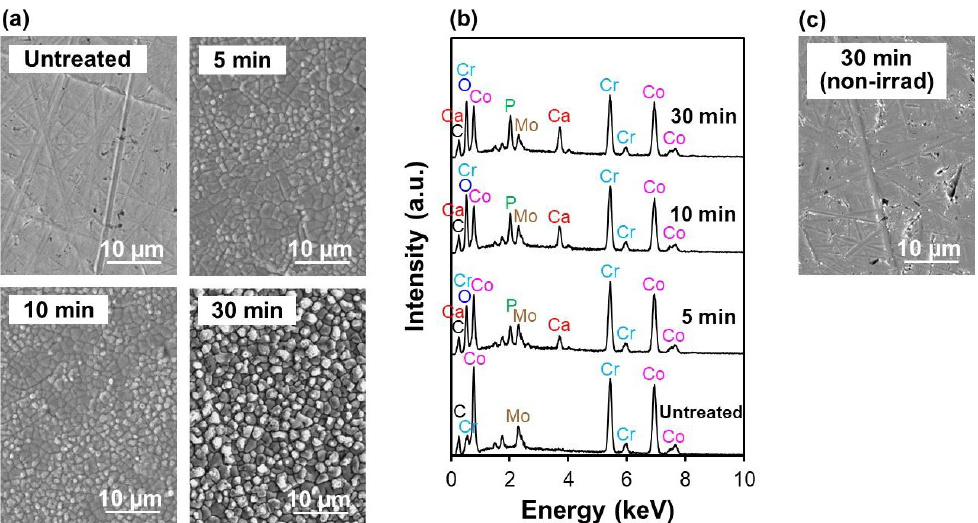
Figure 2. ( a ) Scanning electron microscopy (SEM) images and ( b ) energy-dispersive X-ray (EDX) spectra of the laser-irradiated surfaces of the untreated and LAB-processed (5, 10 and 30 min) Co−Cr alloy substrates. ( c ) SEM image of the non-irradiated surface of the LAB-processed (30 min) Co−Cr alloy substrate. The C peak in ( b ) is derived from the carbon coating that was applied to the substrate surface prior to the SEM-EDX analysis.